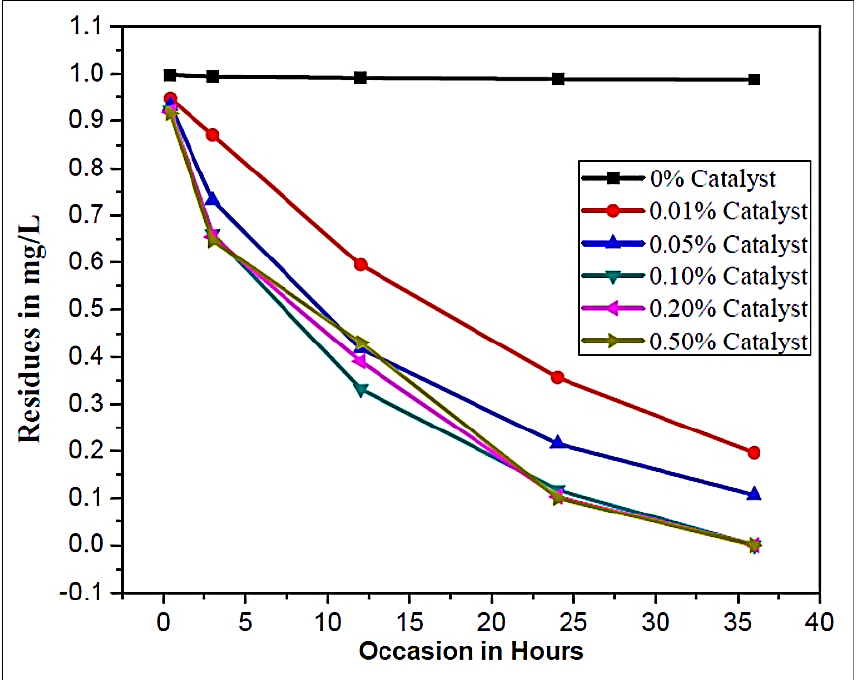
Figure 8. Plot representing the effect of catalyst amount on decontamination of mancozeb in water under direct